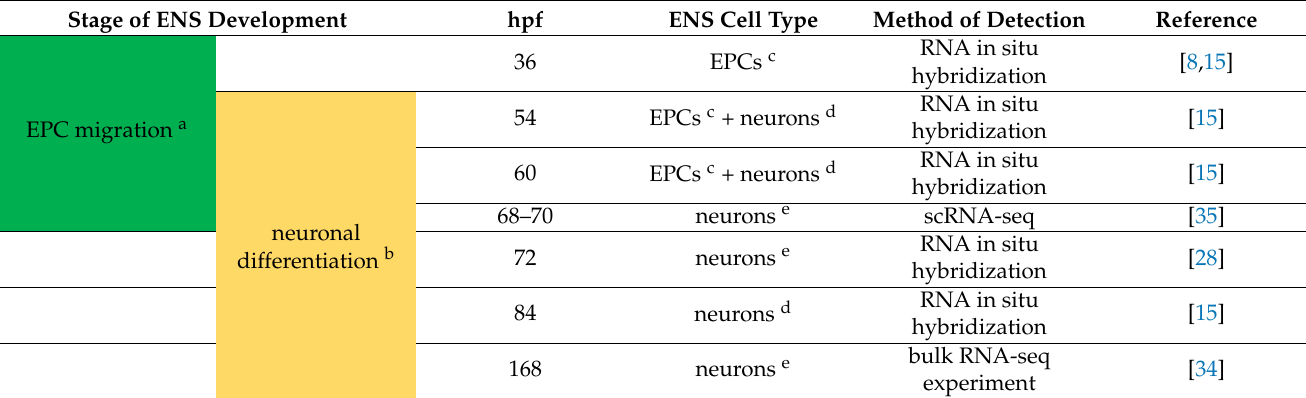
Table 1. Overview of ret expression patterns during ENS